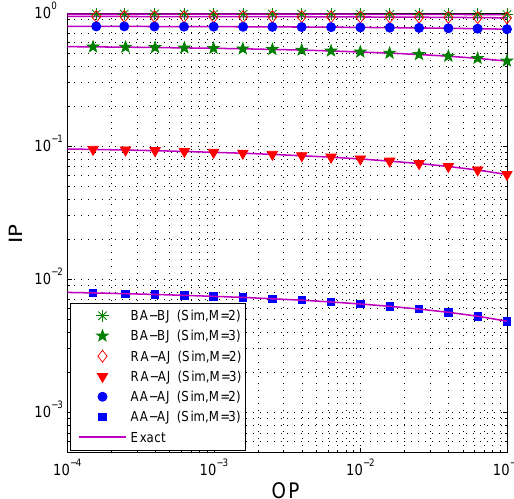
Figure 10. IP as a function of OP when C N E = 4 , α = 0 . 1 , K = 7 and µ 2